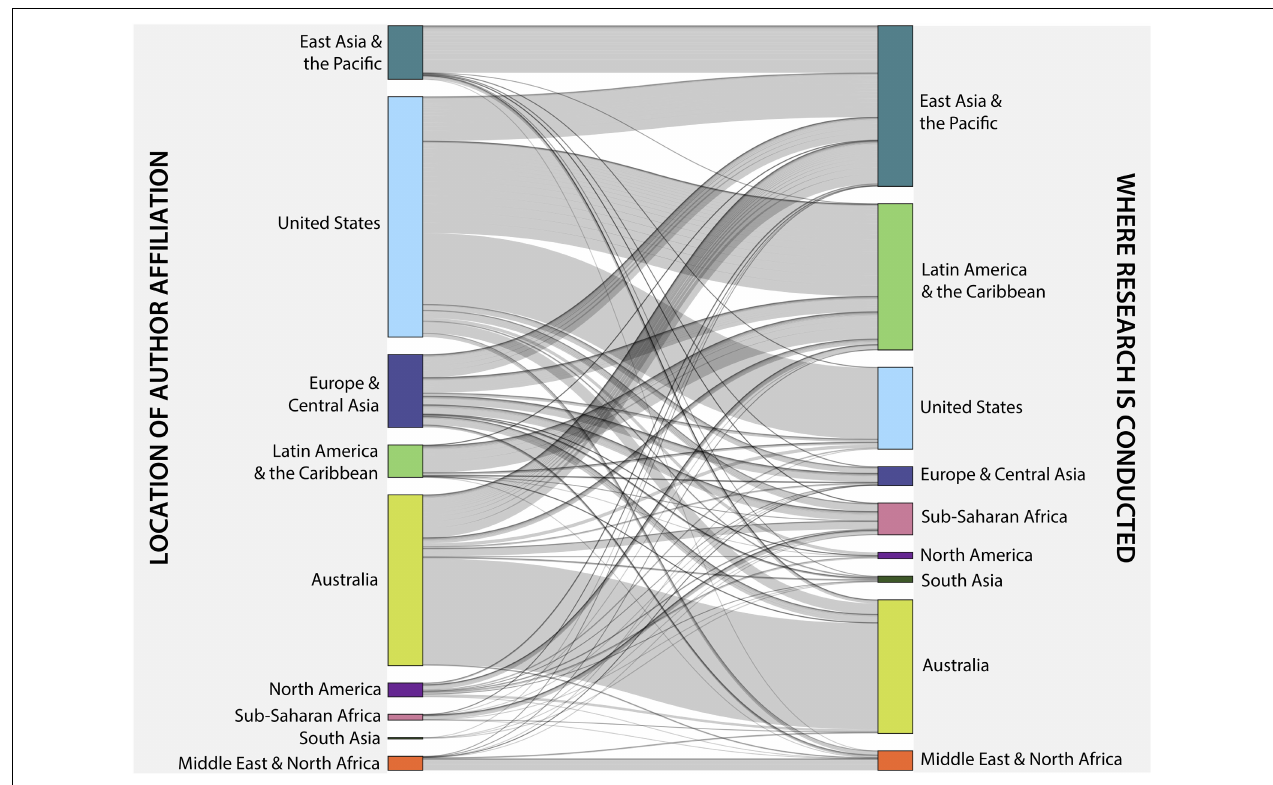
FIGURE 2 | Connections between author affiliations (left) and the location of conducted research (right) . Each connection represents a unique article; authors may be represented more than once across multiple institutions and articles over time. Groupings follow World Bank regions except for the United States shown separately from North America (which here represents Canada, Bermuda) and Australia shown separately from East Asia and the Pacific because of the large number of publications from these two nations.